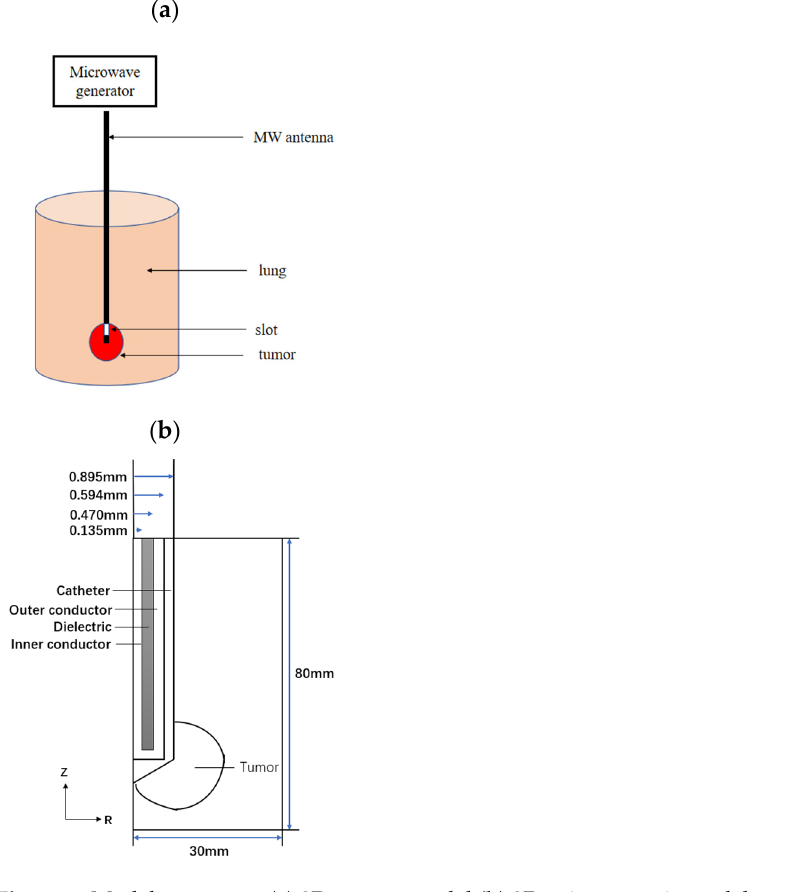
Figure 1. Model geometry: ( a ) 3D porous model ( b ) 2D axisymmetric model.